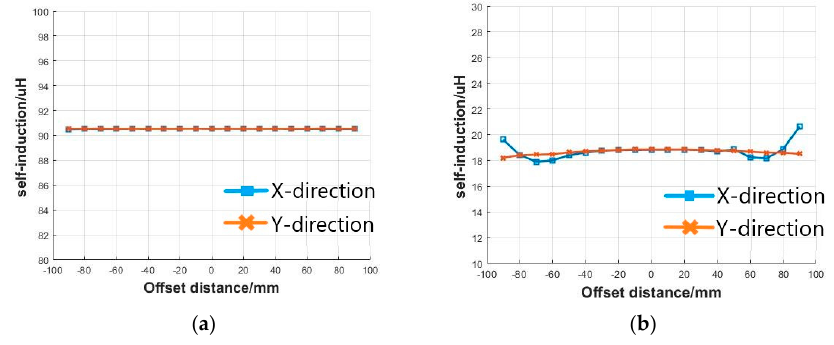
Figure 14. ( a ) Variation of the original side self-inductance. ( b ) Variation of the secondary side